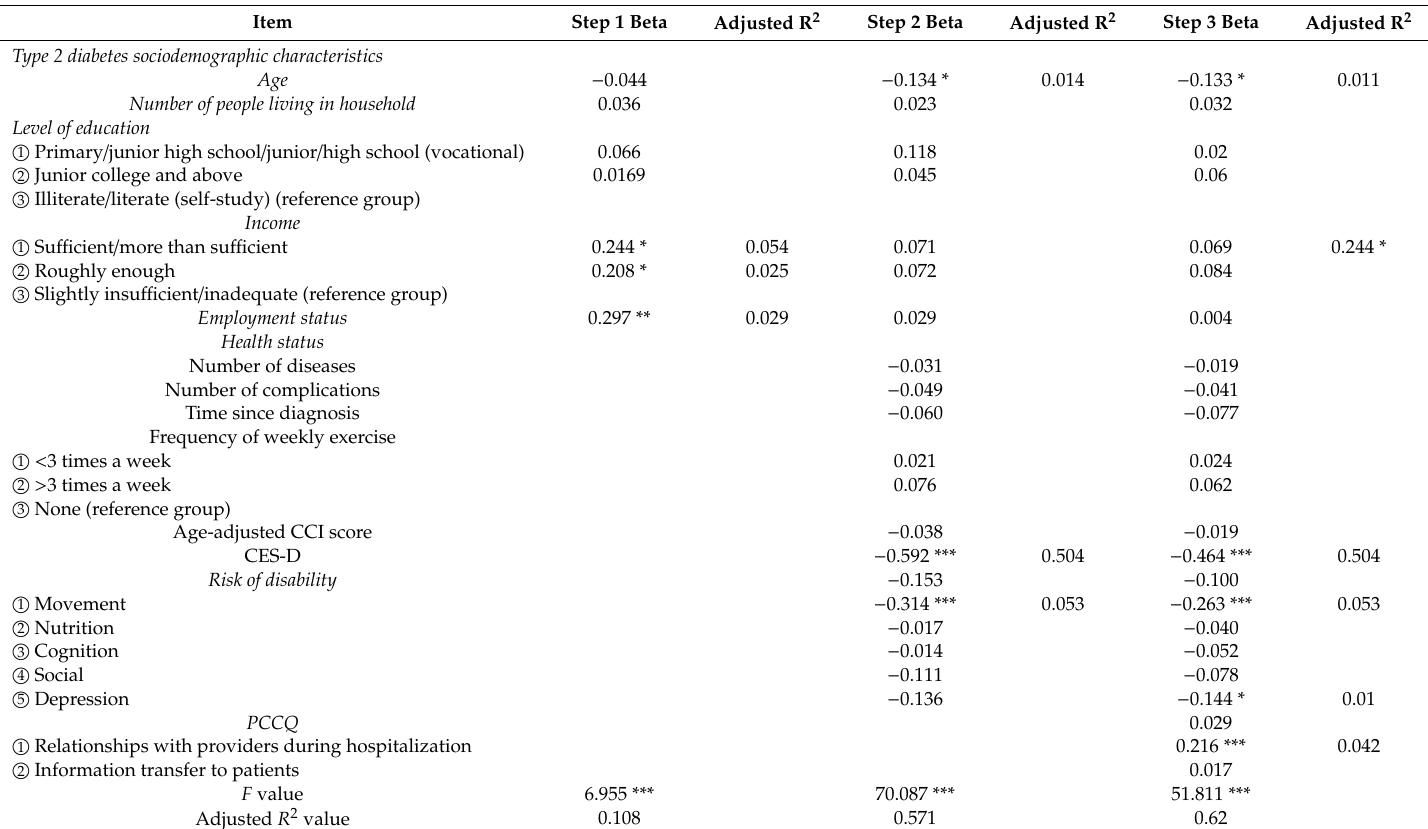
Table 3. Correlations among sociodemographic characteristics, health status, risk of disability, continuity of care, and quality of life among patients with type 2 diabetes ( N = 157).